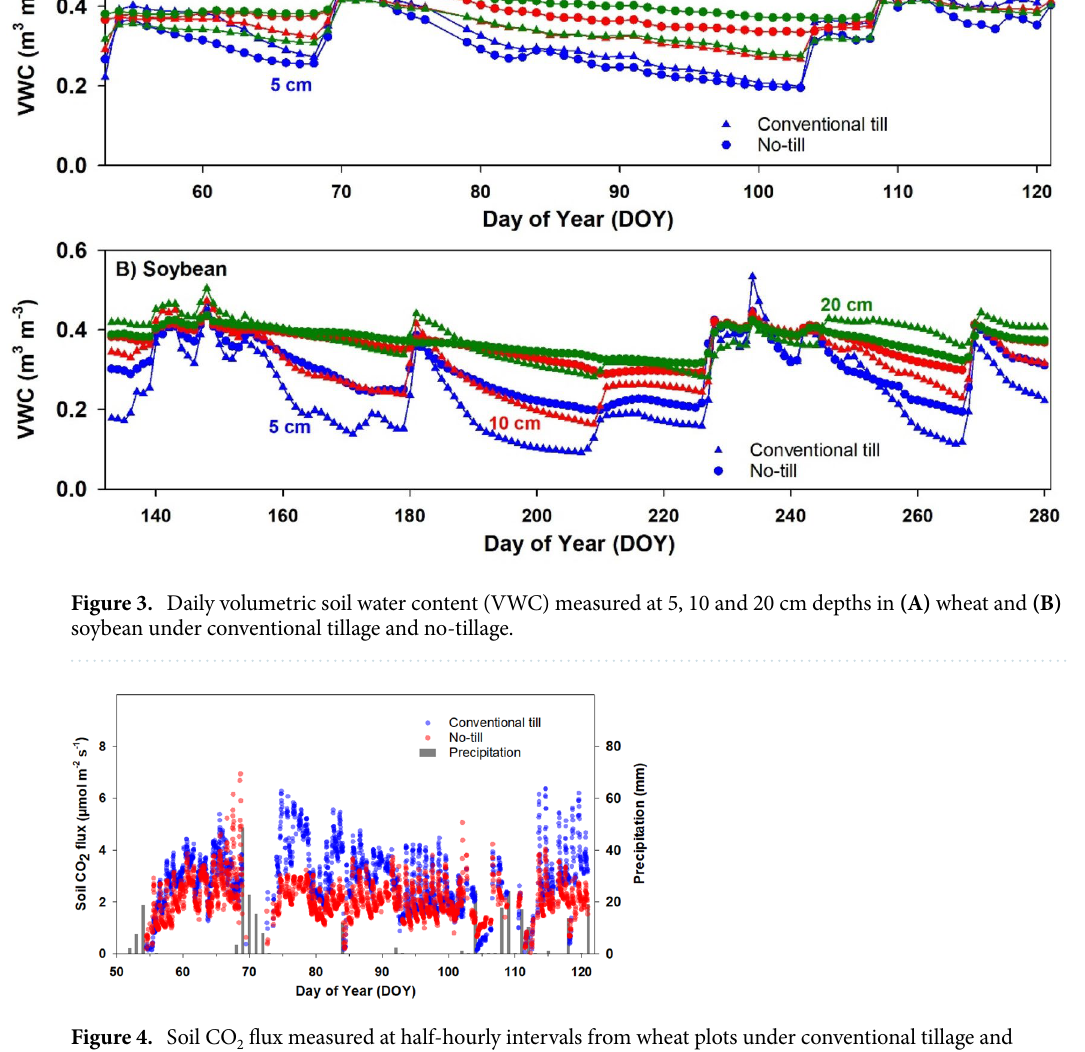
Figure 4. Soil CO 2 flux measured at half-hourly intervals from wheat plots under conventional tillage and no-tillage. Total number of half-hourly measurements is